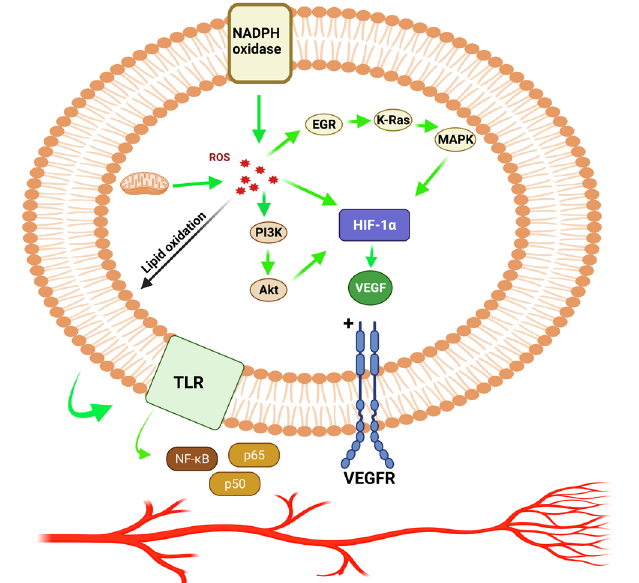
Figure 3. HIF-1α promotes angiogenesis by allowing ROS to speed up the process. EGR: early growth response; K-Ras: Kirsten rat sarcoma virus; VEGFR: vascular endothelial growth factor